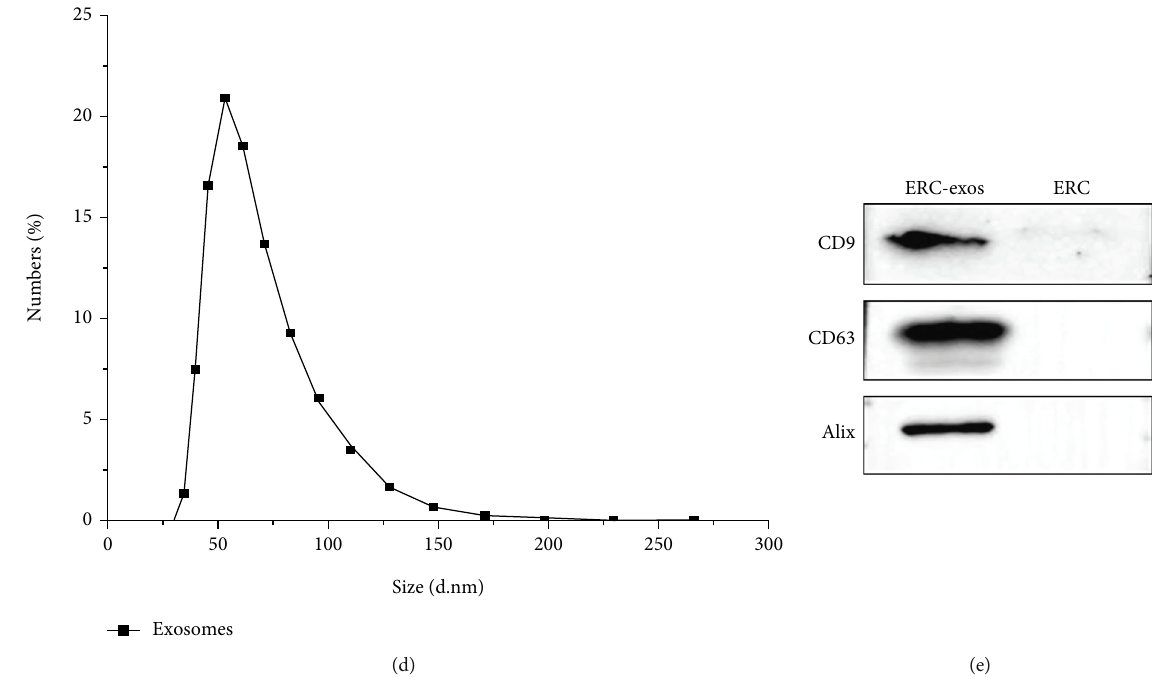
Figure 2: Identi fi cation of ERCs and ERC-exos. (a) Morphology of ERCs at P3. (b) Flow cytometry analysis of surface markers of ERCs. (c) Representative image of exosomes. (d) Particle size distribution of exosomes. (e) Immunoblot of exosome markers (CD9, CD63, and